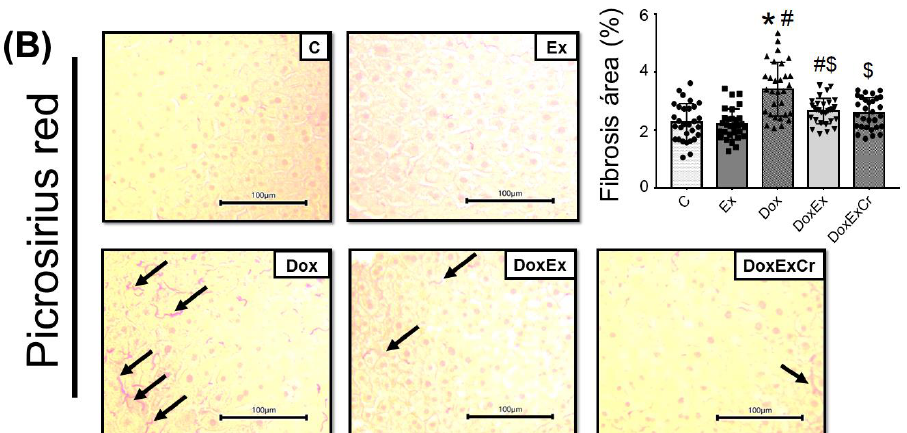
Figure 3. Creatine potentiates ST protection against doxorubicin-induced histopathological alterations. Asterisk indicates cellular degeneration and arrows indicates fibrosis and necrotic areas. Representative ( A ) H&E-stained liver sections and histopathological scores (i.e., cellular degeneration, infiltrate of interstitial inflammatory cells, necrotic zones, and alteration of tissue organization). Representative ( B ) picrosirius red-stained liver sections and percentage of hepatic fibrosis-stained area for groups control (C, n = 6), exercised (Ex, n = 6), treated with doxorubicin (Dox, n = 6), treated with doxorubicin and exercised (DoxEx, n = 6), and treated with doxorubicin, exercised, and supplemented with creatine (DoxExCr, n = 6). Values are median and interquartile intervals. Differences between the groups were surveyed by Kruskal–Wallis using Dun’s post hoc test. Illustrative panels show representative photomicrographs taken under 20× magnification. * indicates a significant difference from control group; # indicates a significant difference from the exercised group; $ indicates a significant difference from the doxorubicin-treated group; and & indicates a significant difference from the doxorubicin-treated exercised group. H&E, hematoxycillin and eosin.